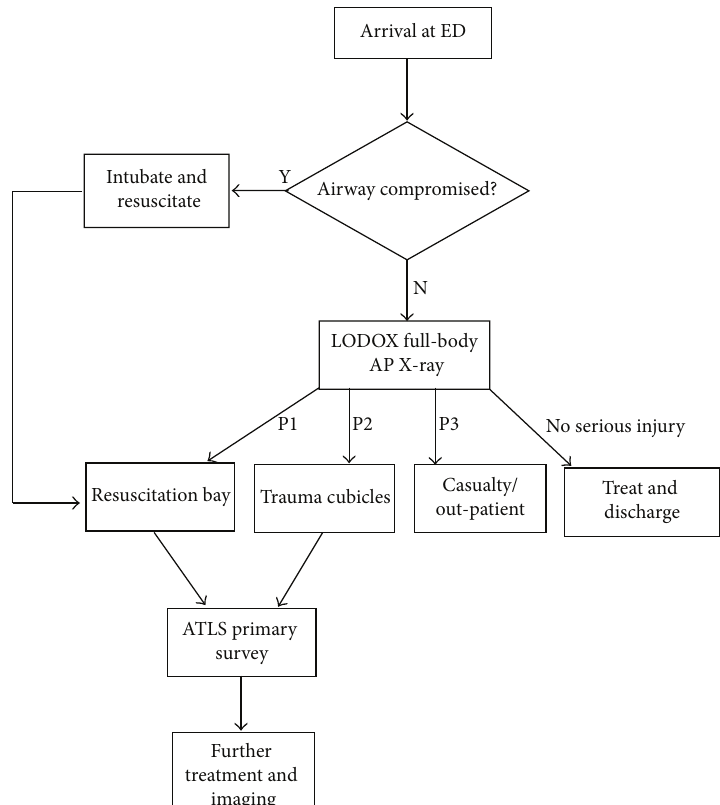
Figure 2: Flowchart outlining the Johannesburg trauma protocol.